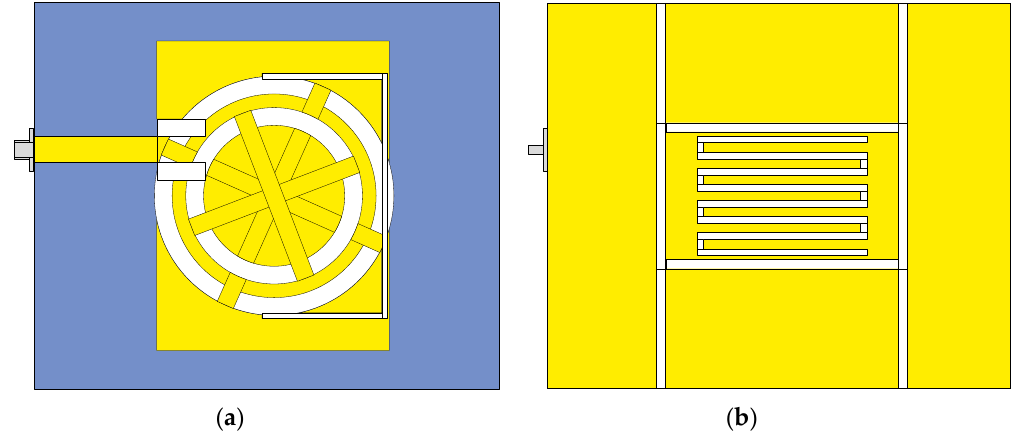
Figure 4. Final antenna layout for the two-frequency bands optimization case, after the optimization process. ( a ) Front view; ( b ) bottom view.